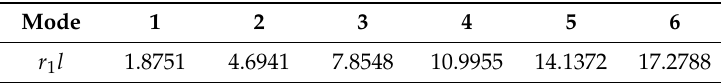
Table 3. First six solutions of r 1 l for fixed-free double-beam